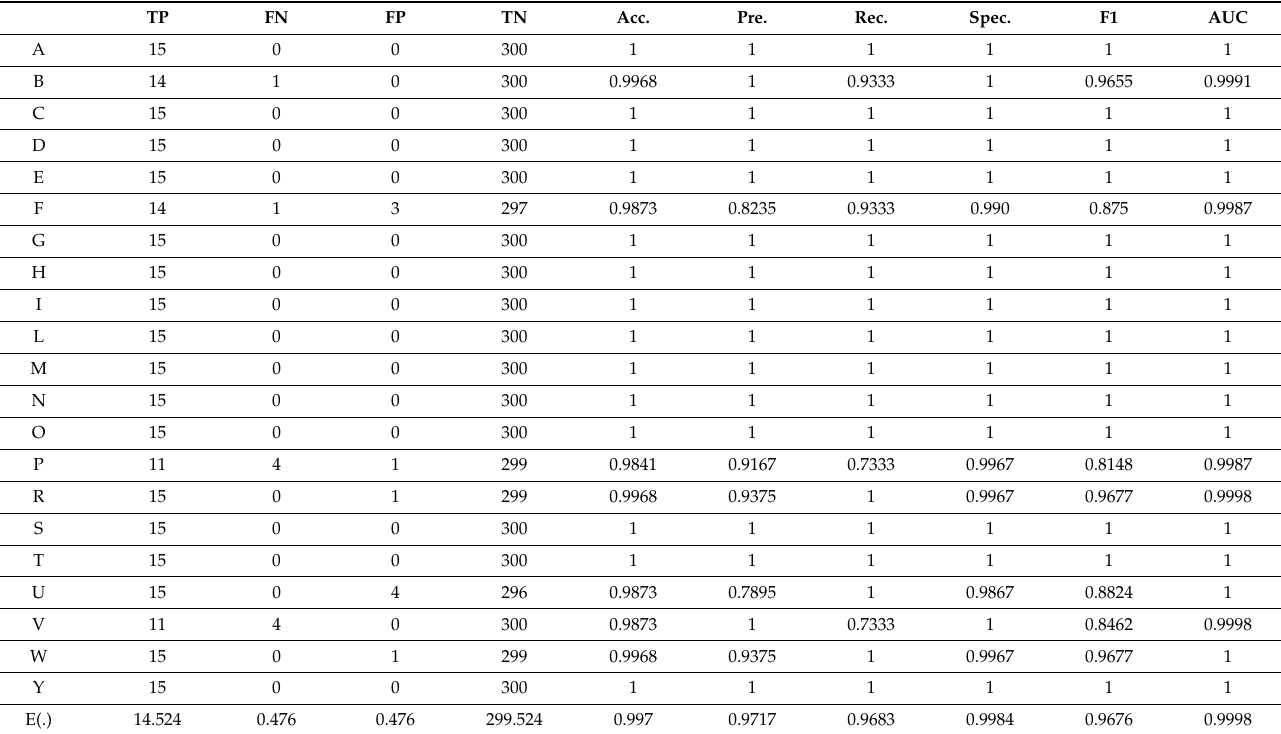
Figure 12. Cumulative confusion matrix for Cartesian features for cross-validation with k = 15. Rows show the actual classes, and columns show the predicted classes. The confusion matrix ( i , j ) displays the total numbers of test examples with actual class i and predicted class j . The values of TP, TN, FP, FN, and the metrics for each class corresponding to the confusion matrix in Figure 12 are shown in Table 5. Table 5. Numbers of false negatives (FN), false positives (FP), true negatives (TN), and true positives from the confusion matrix for the Cartesian features in Figure 12, for each class. For each class, the metrics of accuracy (Acc.), precision (Pre.), recall (Rec.), specificity (Spe.), F1 score, and area under the curve (AUC) of the received operating characteristic (ROC) are computed. The last row E(.) displays the average for each column.